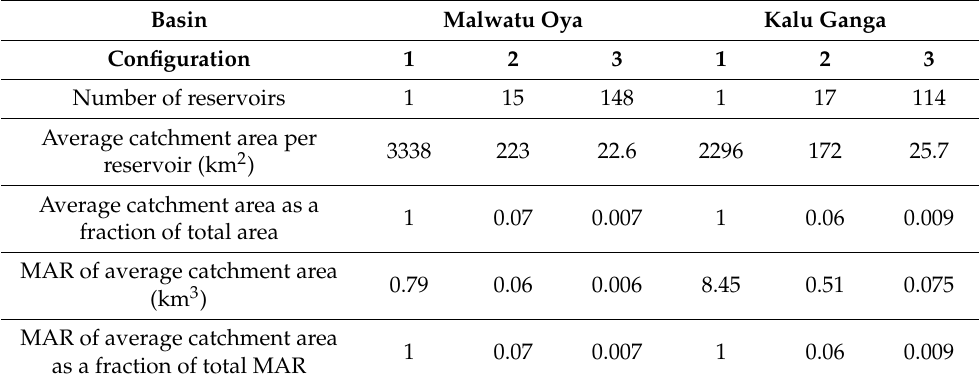
Figure 3. Three reservoir system configurations in Kalu Ganga ranging from one large hypothetical reservoir at the downstream end to 17 medium-size reservoirs in large sub-basins and 114 smaller reservoirs in minor sub-basins. Table 1. Main features of reservoir system Configurations 1, 2, and 3.